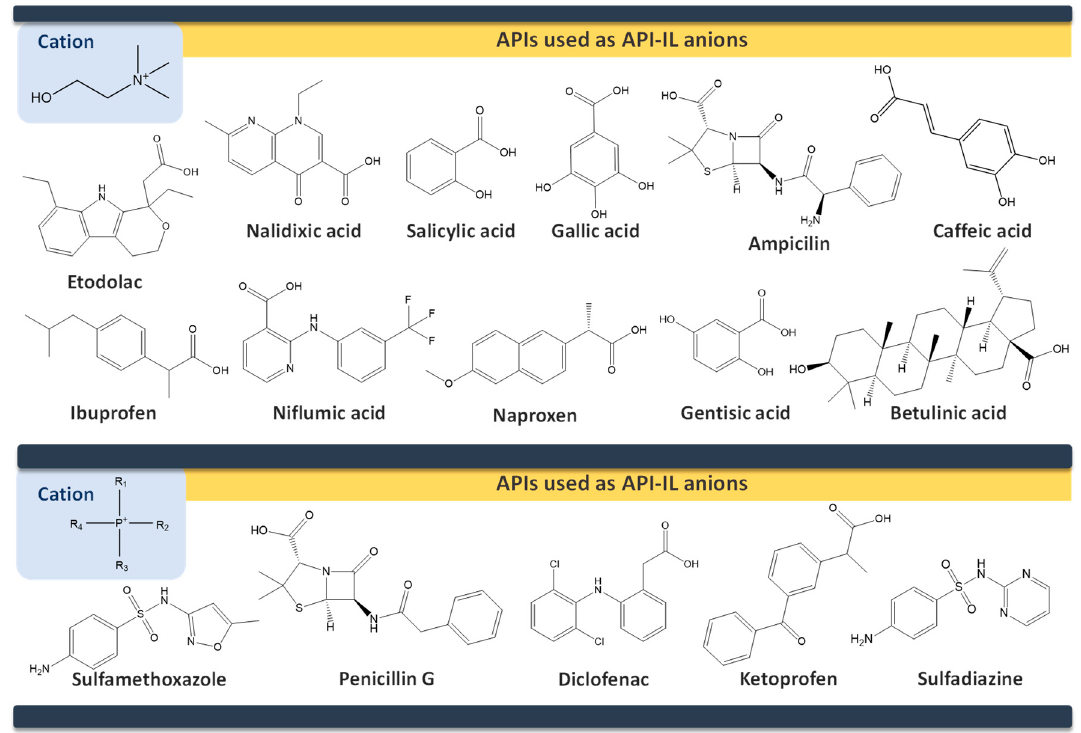
Figure 11. Selected examples of cations and anions used in API-ILs preparation (adequate references are given along the current section).